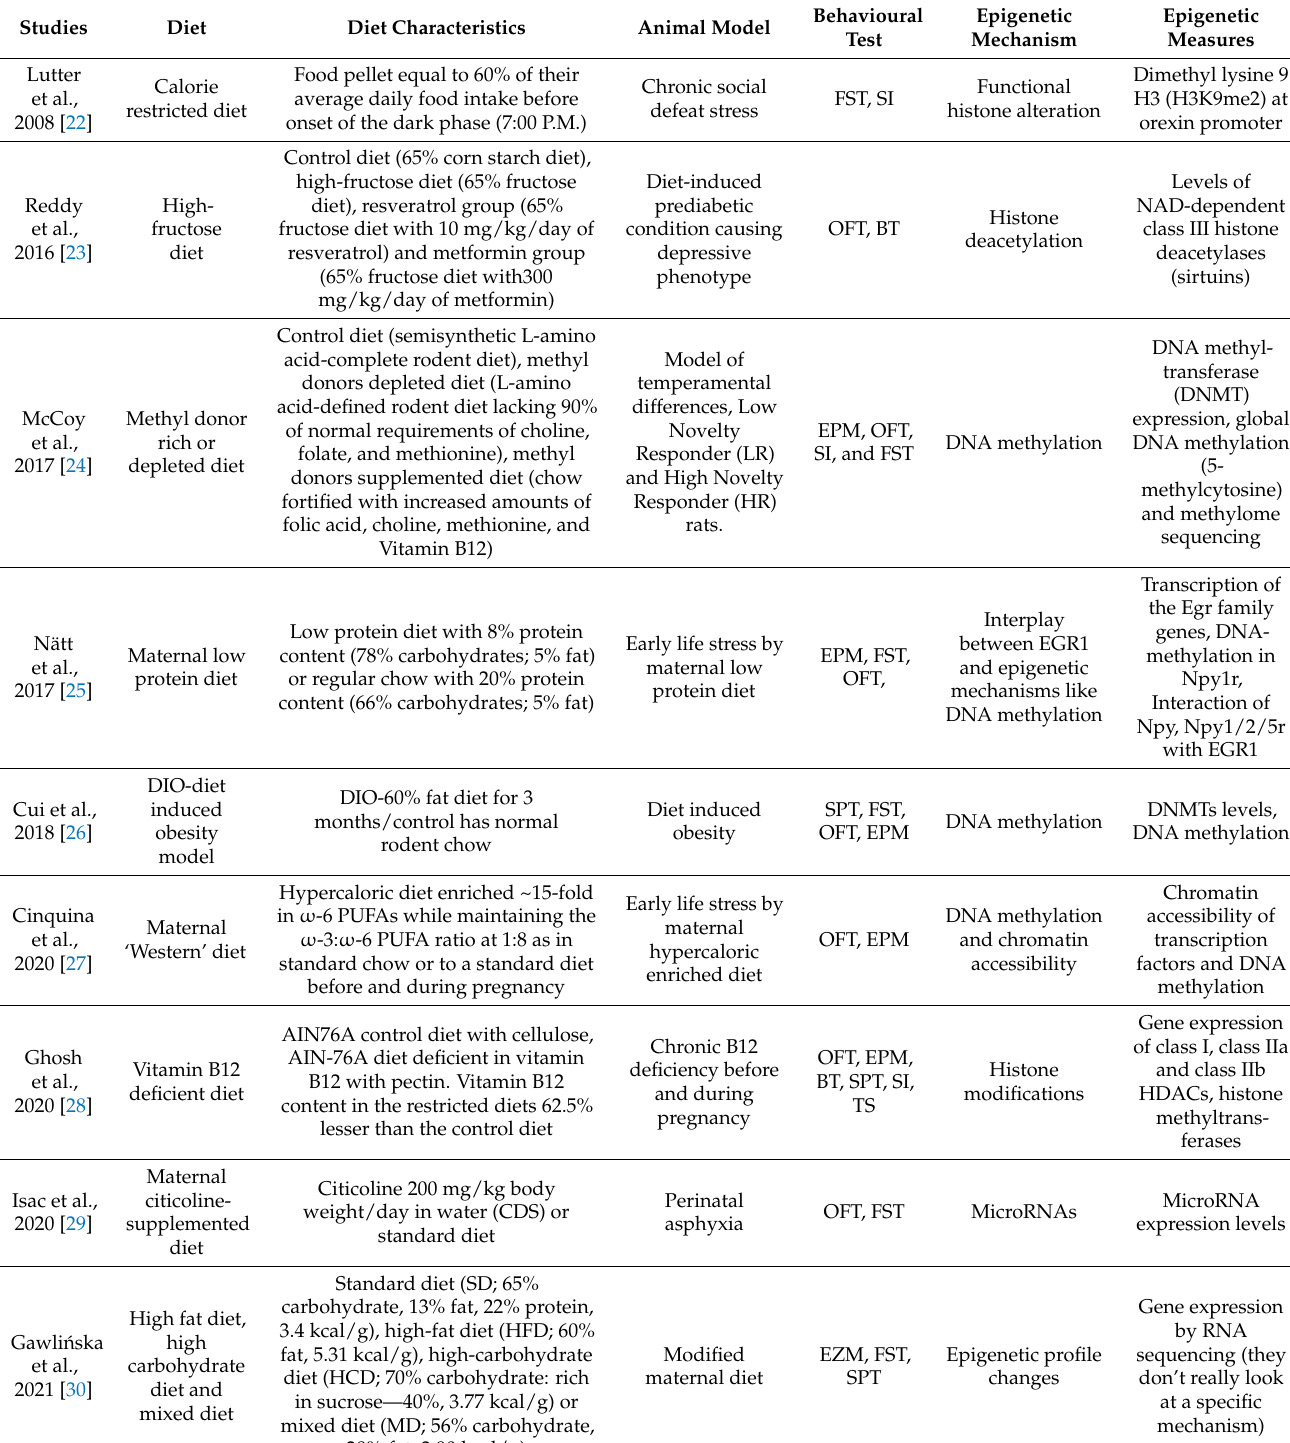
Table 3. Diet, behaviour and epigenetic characteristics of included